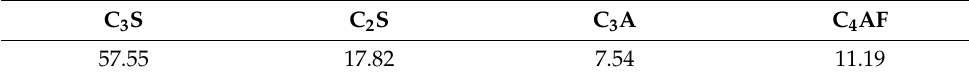
Table 2. Mineral composition of reference cement clinker (wt.%).